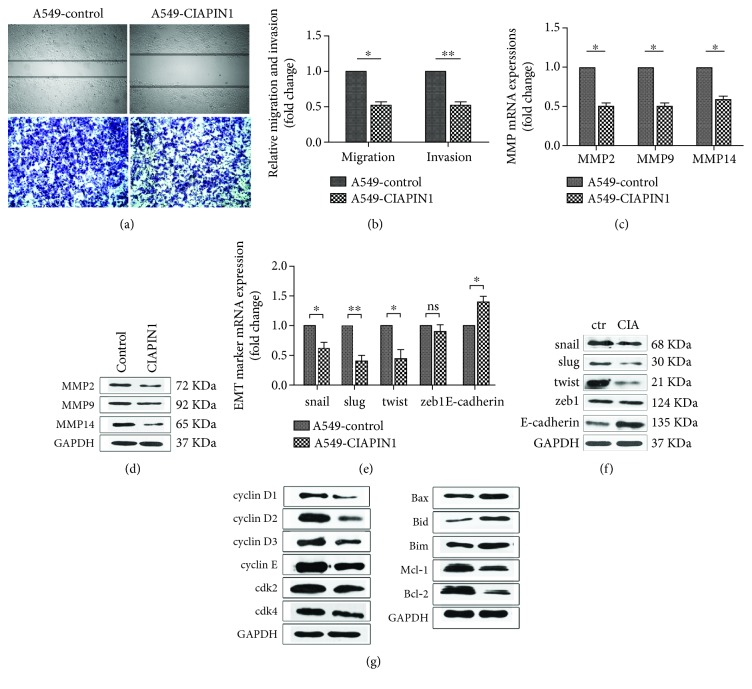
Effect of CIAPIN1 upregulation on NSCLC A549 cells' metastatic potential was measured. (a) Representative images of cells' migration and invasion were taken. (b) The relative cells' migration and invasion after CIAPIN1 upregulation were measured. (c, d) The mRNA expression and the protein levels of MMP2, MMP9, and MMP14 were detected by real-time quantitative PCR and western blotting. (e, f) The mRNA expression and the protein levels of snail, slug, twist, zeb1, and E-cadherin were detected by real-time quantitative PCR and western blotting. (g) Expressions of cell cycle- and apoptosis-associated proteins were detected by western blotting. The expressions of cyclin D1, cyclin D2, cyclin D3, cyclin E, cdk2, and cdk4 were detected in A549 cells with CIAPIN1 overexpression. The expressions of Bax, Bid, Bim, Bcl-2, and Mcl-1 were detected in A549 cells with CIAPIN1 overexpression. GAPDH was used as an internal control. Each value indicated the mean ± SD of three independent experiments. ∗P < 0.05, ∗∗P < 0.01, compared with control.